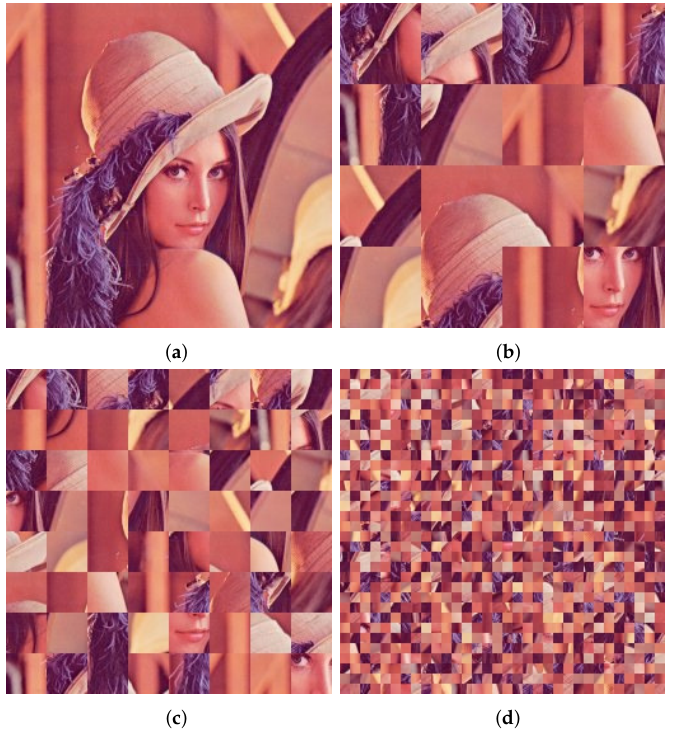
Figure 2. Examples of the Jigsaw transform on an RGB image by varying the number of subsections ( M ). ( a ) RGB image. ( b ) M = 16, blocks of 64 × 64 pixels. ( c ) M = 64, blocks of 32 × 32 pixels. ( d ) M = 1024, blocks of 8 × 8